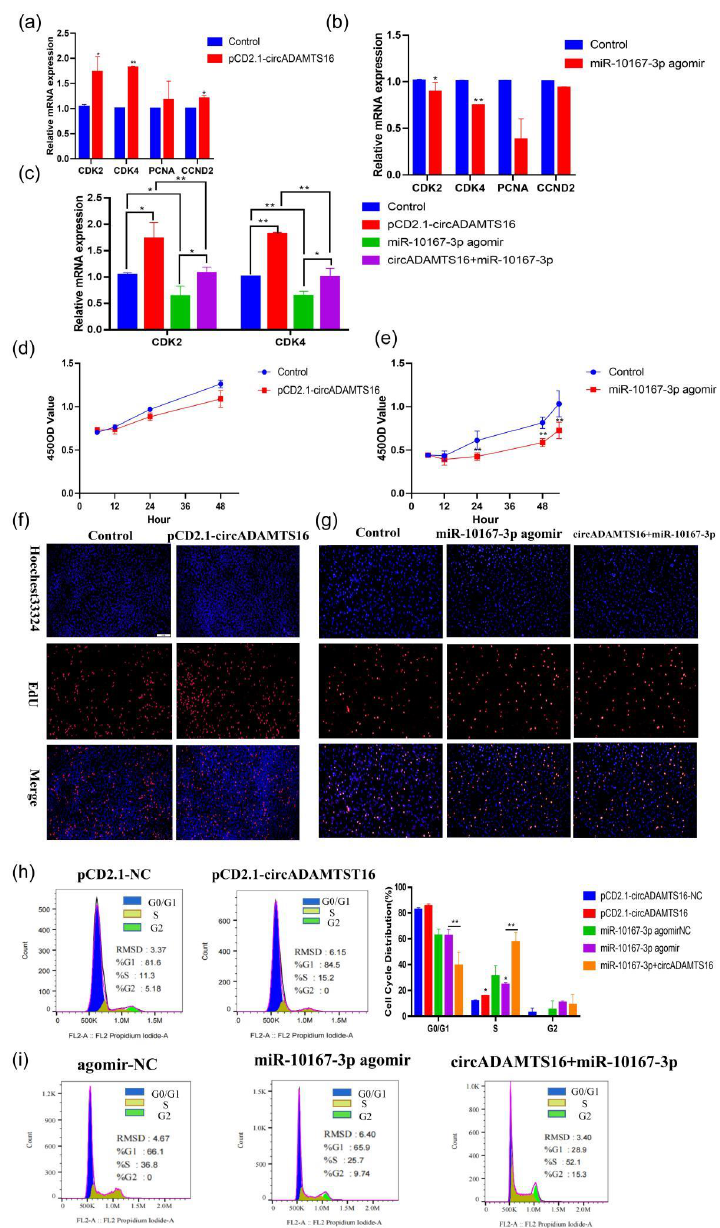
Figure 3. circADAMTS16 promotes the proliferation of bovine adipocytes by targeting miR-10167-3p. ( a , b ) qPCR was used to detect the mRNA expression levels of proliferation genes CDK2 and CDK4 after transfection of pCD2.1-circADAMTS16 and miR-10167-3p agomir, respectively. ( c ) the expression levels of proliferation genes CDK2 and CDK4 were detected after co-transfection of circADAMTS16 and miR-10167-3p agomir into bovine adipocytes. ( d , e ) The viability of pCD2.1-circADAMTS16 and miR-10167-3p agomir transfected cells was detected by CCK-8. ( f , g ) Cell proliferation was detected by EdU. ( h , i ) Cell cycle was analyzed by flow cytometry (pCD2.1-NC was empty, and agomir-NC was used as the control of specially synthesized agomir). Scale bar indicates 200 µ m. * p < 0.05, ** p <